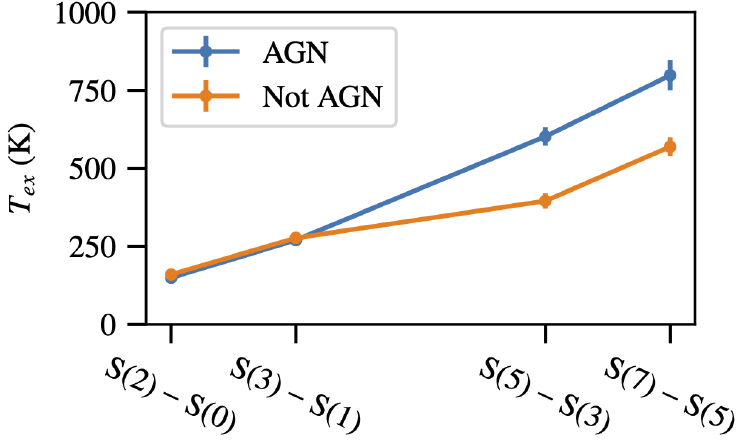
Figure 13. The H 2 excitation temperature for mid-IR AGN vs. non-AGN calculated from each pair of mid-IR ro-vibrational transitions, as labeled. This result highlights that the presence of an AGN directly affects the ISM of its host galaxy. Adapted from Lambrides et al. [69] with permission from the